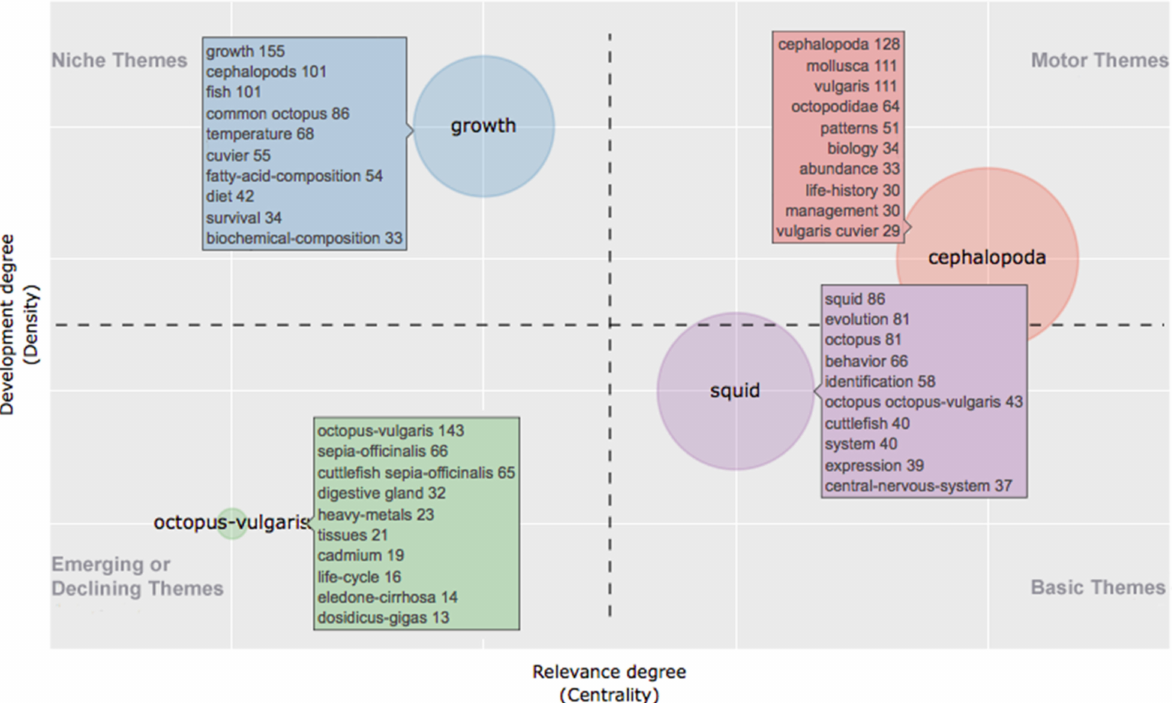
Figure 3. Thematic map showing clusters and the KeyWords Plus from 2011 to 2020 (“recent period”) identified by the co-occurrence network. The X -axis represents the centrality (i.e., the degree of interaction of a network cluster in comparison with other clusters) and gives information about the importance of a theme. The Y -axis symbolizes the density (i.e., measures the internal strength of a cluster network, and it can be assumed as a measure of the theme’s development). Accordingly, the first quadrant identifies motor themes (i.e., they are well developed and important for the structuring of a research field); in the second quadrant are plotted highly developed and isolated themes (i.e., they are of limited importance for the field); the third quadrant contains emerging or declining themes (i.e., they are weakly developed and marginal); the fourth quadrant includes basic and transversal themes (i.e., themes concerning general topics transversal to different research areas of the